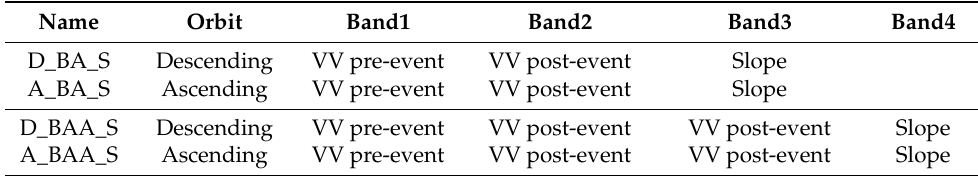
Table 3. Name and characteristics of the composite images created.